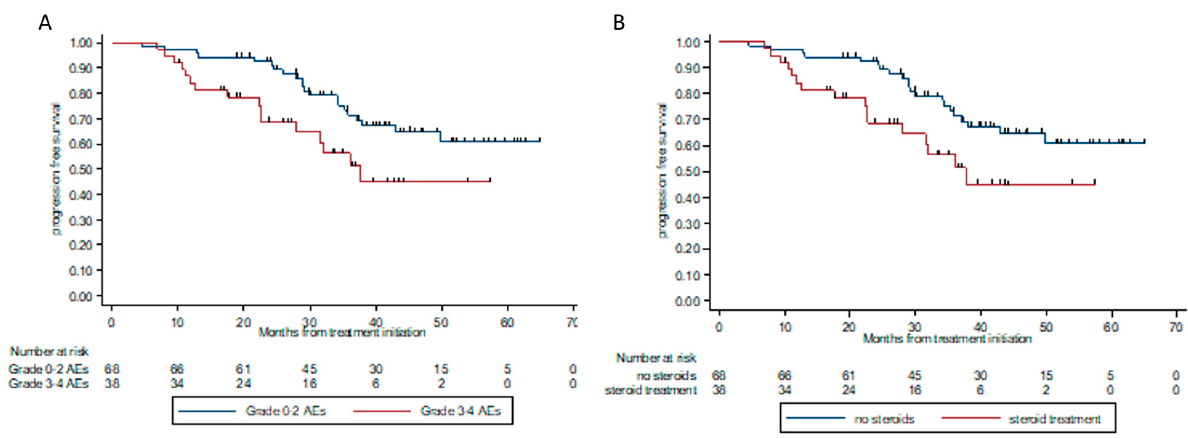
Figure 7. Individual clinical courses of all patients treated with immunotherapy who discontinued treatment in the ab- sence of disease progression. Data is presented from treatment initiation to the last follow-up or death. Patients were sorted according to disease progression and steroid exposure. Patients achieving CR were less likely to have disease pro- gression at treatment discontinuation (24%), compared to patients achieving PR or SD as best response (50% and 100%,